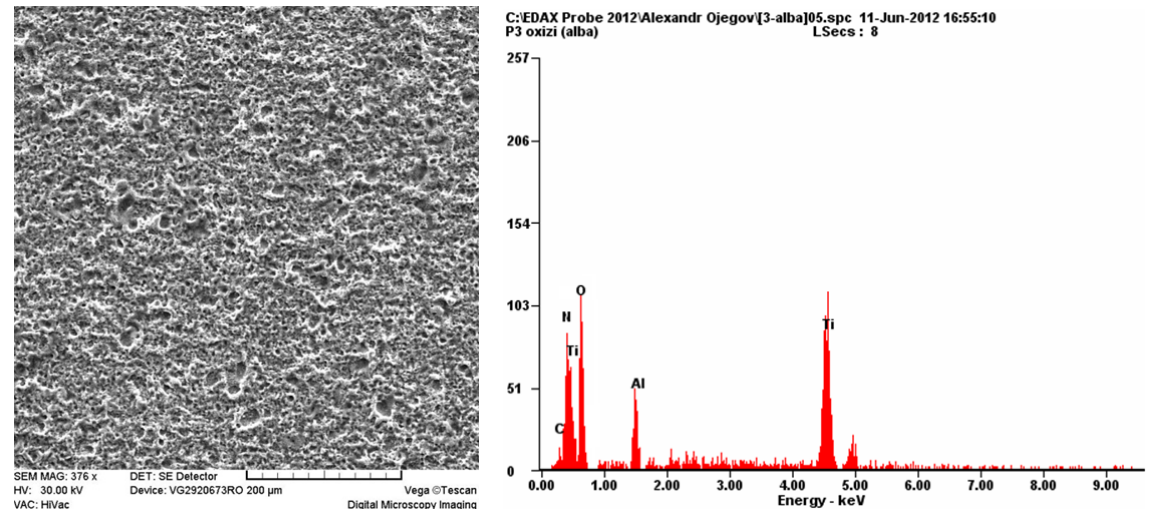
Figure 3. SEM and EDX analysis of TiAl6Mo4 titanium alloy sample surface